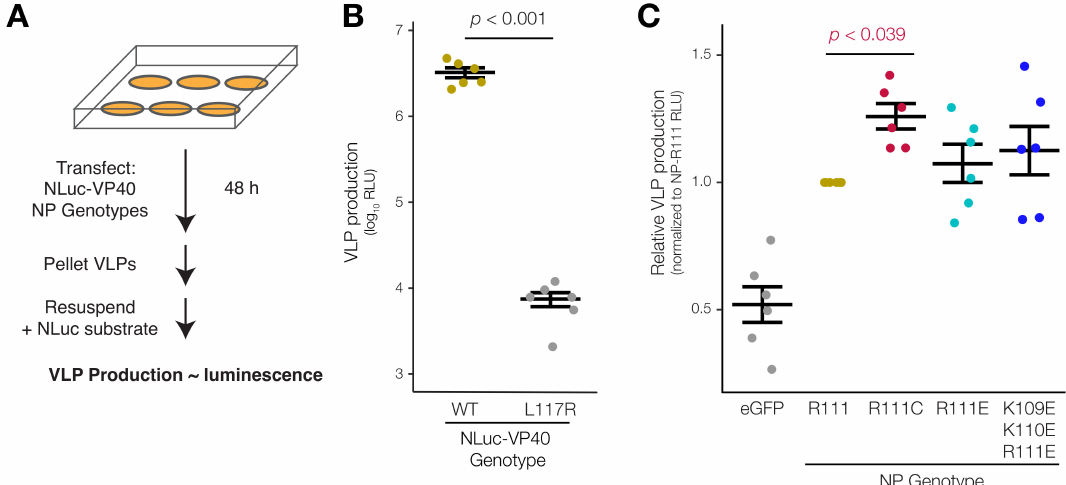
Figure 4. EBOV NP-R111C increases budding of VLPs. ( A ) Schematic of the VLP budding assay. We expressed NLuc fused to EBOV VP40 (NLuc-VP40) in HEK 293FT cells to form luminescent VLPs, and co-expressed NP mutants to measure the impact of NP genotype on VLP budding; ( B ) VLP budding assay control. NLuc-VP40 expression alone resulted in bright luminescence, expressed in relative light units (RLU). VP40 loss-of-function (LOF) mutant L117R failed to form VLPs ( n = 6 biological replicates). We assessed statistical significance by paired t -test. Error bars indicate mean ± standard error of the mean (SEM); ( C ) VLP budding with NP variants. We measured and normalized all NP or eGFP RLU values within each replicate to that replicate’s NP-R111 RLU ( n = 6 biological replicates) and assessed statistical significance using repeated measures ANOVA with Dunnett’s test to correct for multiple hypothesis testing. Error bars indicate mean ±